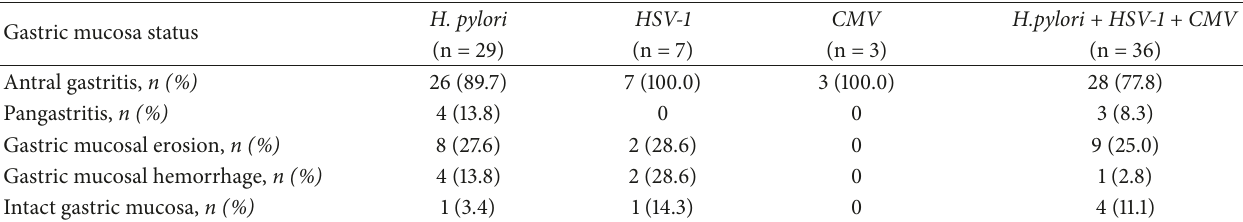
Table 3: Detection rates of Helicobacter pylori , HSV-1 , CMV , and their combinations in various gastric mucosal damages, as evidenced by